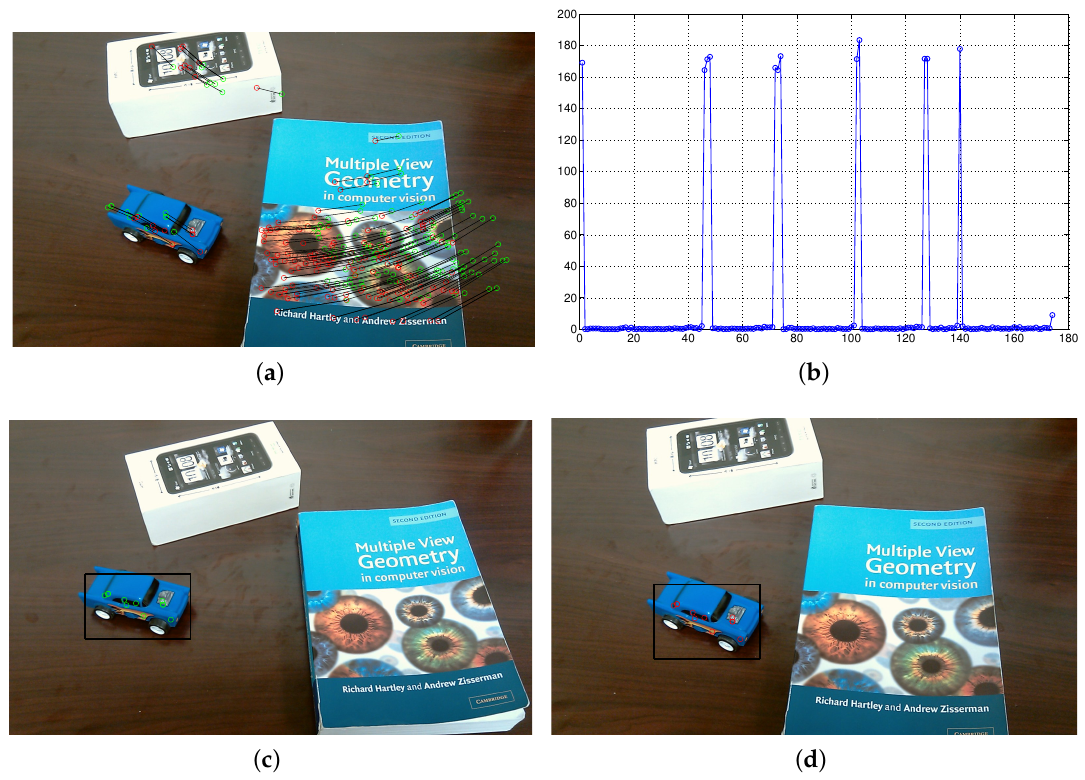
Figure 17. Experimental illustrations for epipolar geometry. ( a ) feature matches; ( b ) distance errors; ( c ) moving toy car detected in first frame; ( d ) moving toy car detected in second